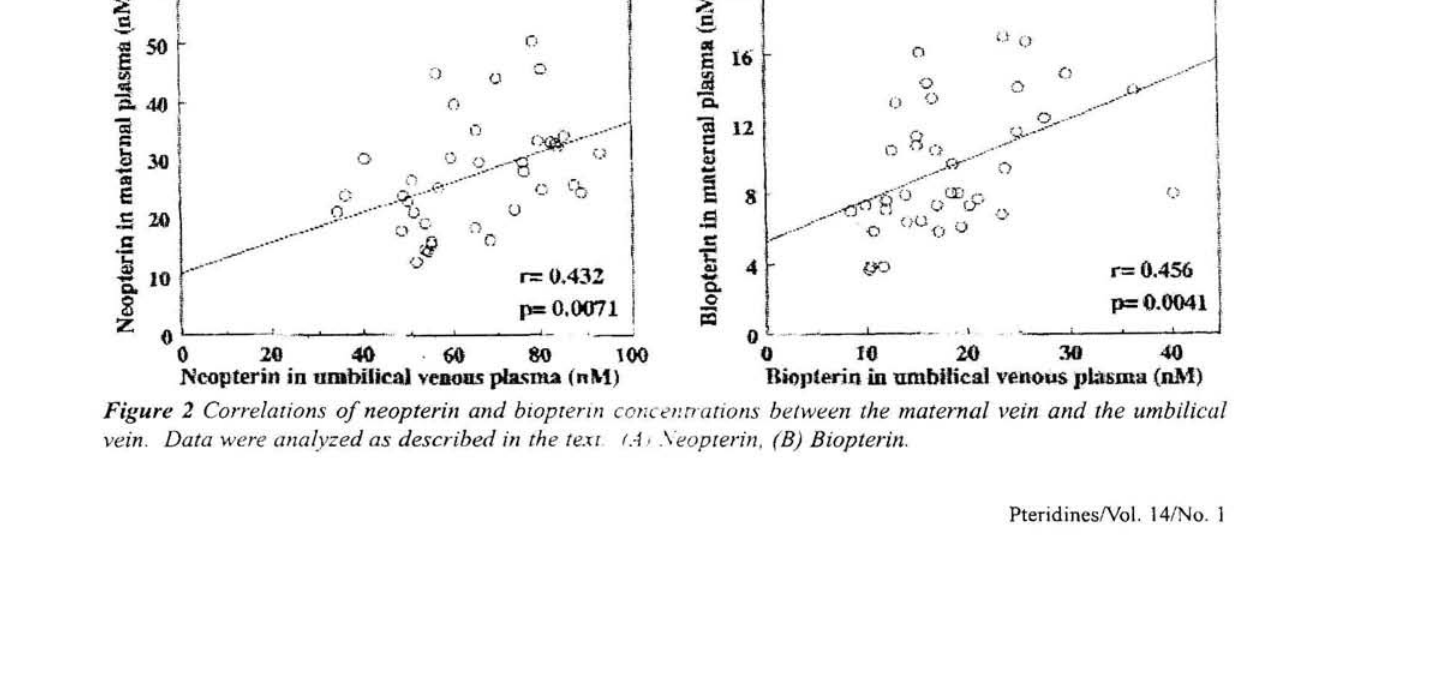
Figure 2 Correlations of neopterin and biopterin conc vein. Data were analyzed as described in the texi lA